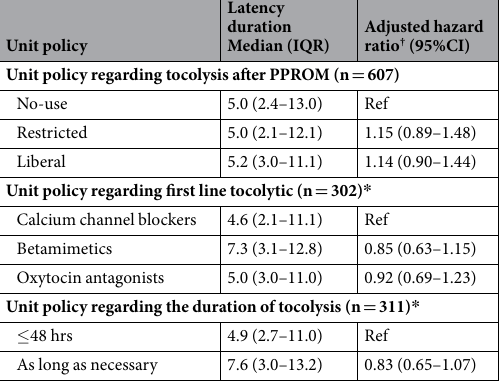
Table 3. Association of unit policy regarding tocolysis after PPROM with latency duration (i.e. time to delivery period). IQR: interquartile range, PPROM: preterm premature rupture of membranes * Among units with liberal policy regarding tocolysis after PPROM † Stratified Cox models (stratification for gestational age at PPROM), with maternity units as level 2 and countries as level 3, and log-normal distribution of the hazard function.